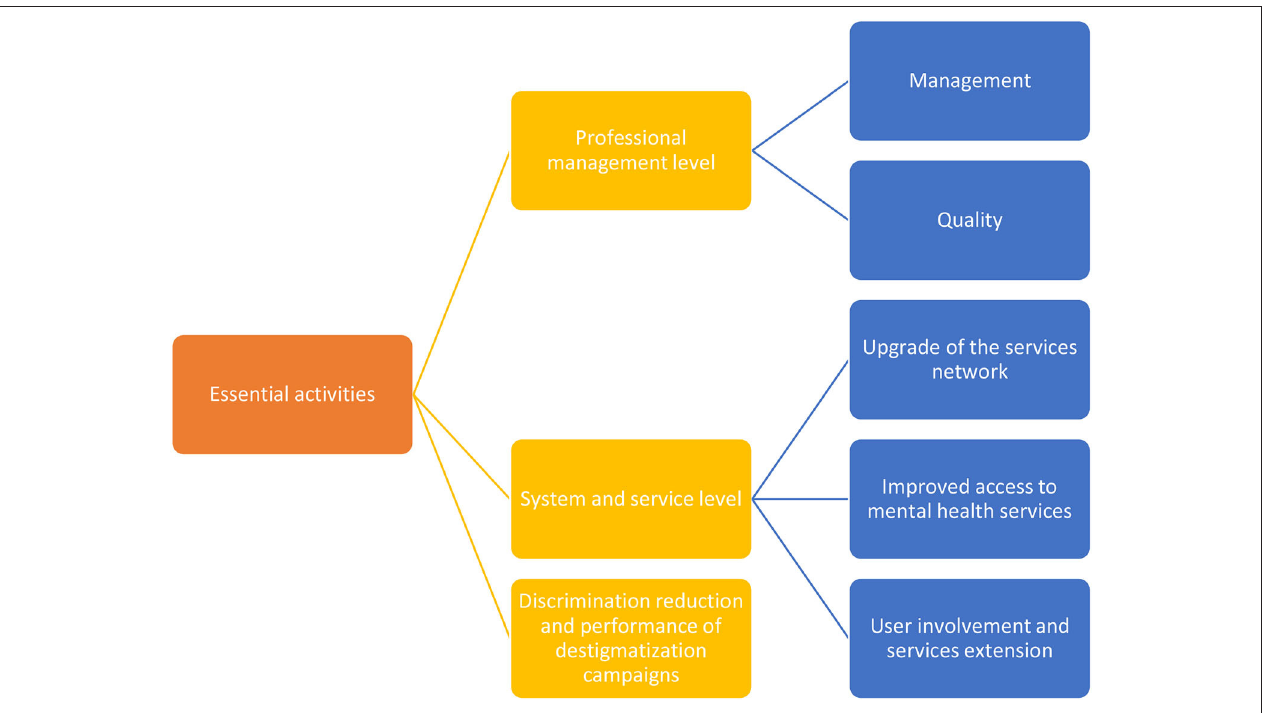
FIGURE 2 | Essential activities during and after the COVID-19 pandemic.